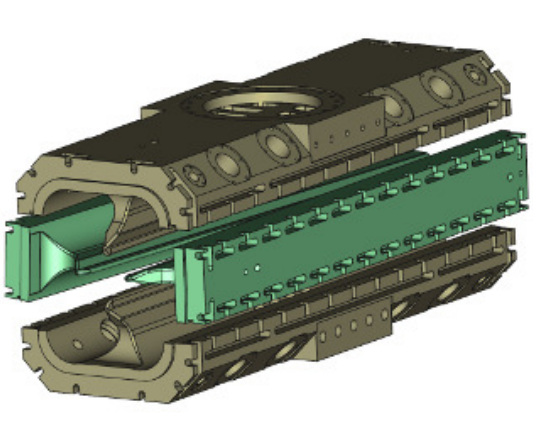
Figure 1. Exploded view of first segment of the RFQ, showing the so-called major and minor vanes.